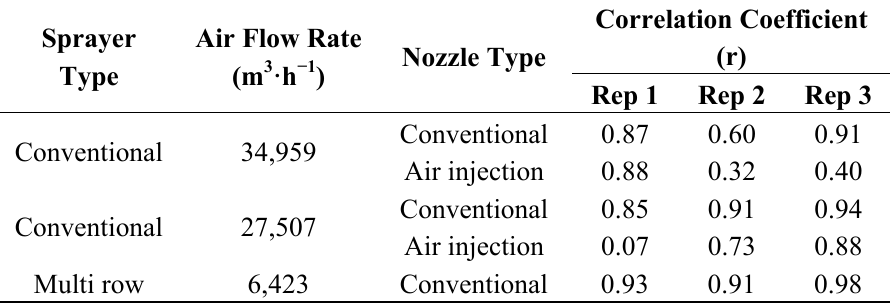
Table 3. Values of correlation coefficient (r) between the number of points detected by LIDAR and the deposition of Tartrazine in the artificial collectors placed in the test bench.